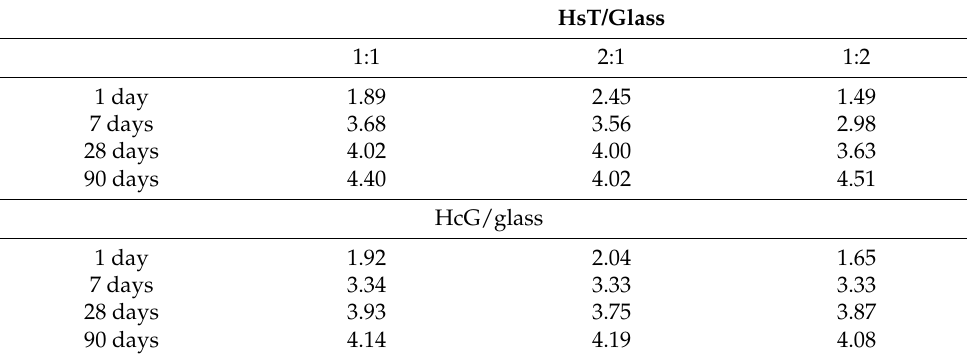
Table 5. Loss of mass (%) between 50–400 ◦ C in all the mixtures under